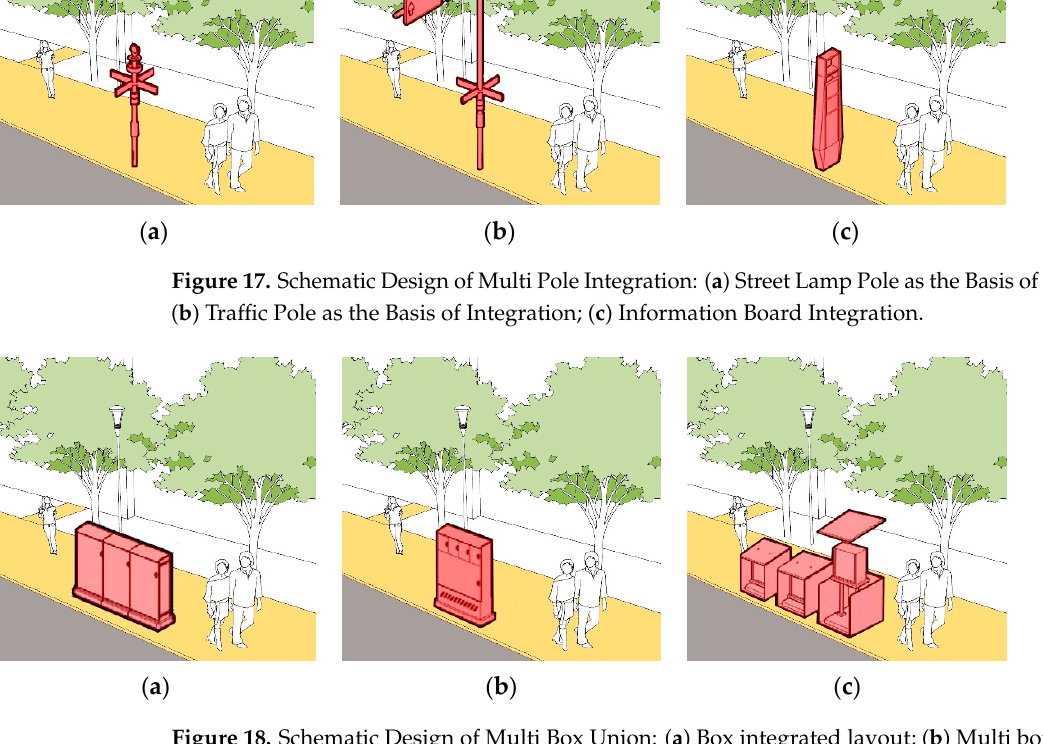
Figure 18. Schematic Design of Multi Box Union: ( a ) Box integrated layout; ( b ) Multi box in one; ( c ) Box